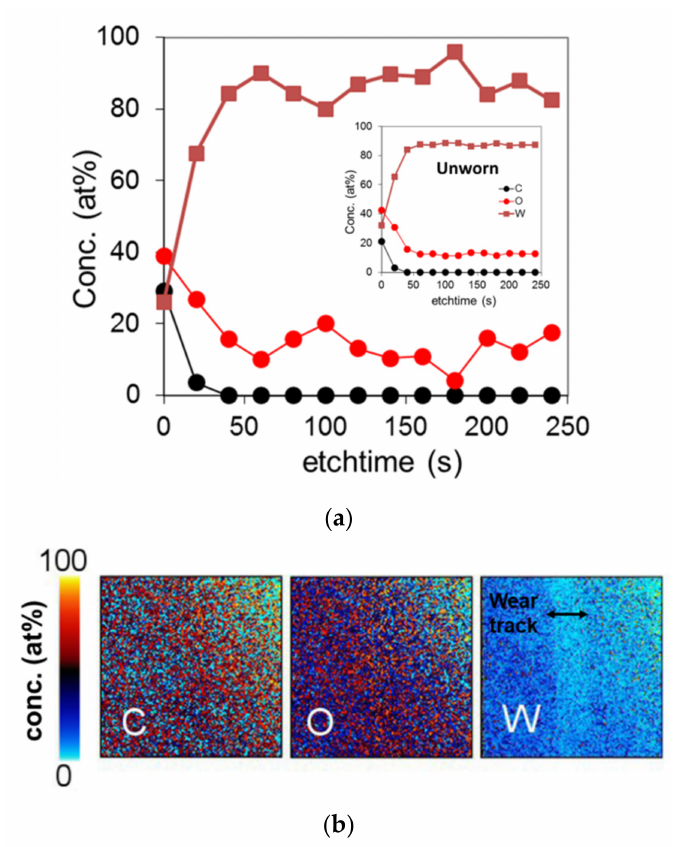
Figure 5. ( a ) XPS depth profile of the worn tungsten surface under dry sliding conditions, including the XPS depth profile of the unworn tungsten surface as a reference. ( b ) Elemental map of the wear track.